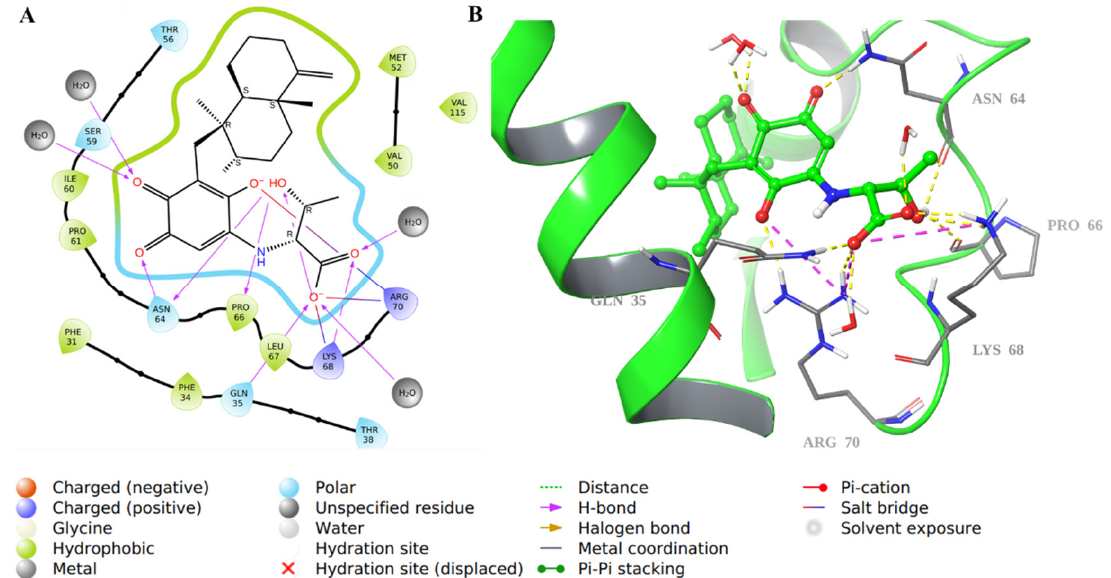
Figure 8. Molecular docking of co-crystallized inhibitor compound 34 in hDHFR (PDB: 1KMV). ( A ) 2D representation of binding interactions of 34 with amino acid residues in the active site within a 3 Å distance; ( B ) 3D representation of 34 in green within the hDHFR active site. The H-bonds and ionic interactions are in yellow and purple dotted lines, respectively.